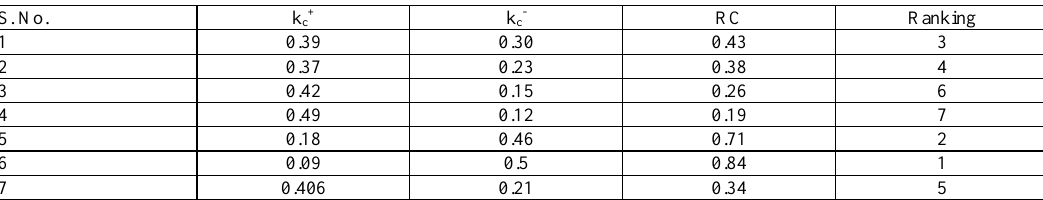
Table 14. Relative closeness and